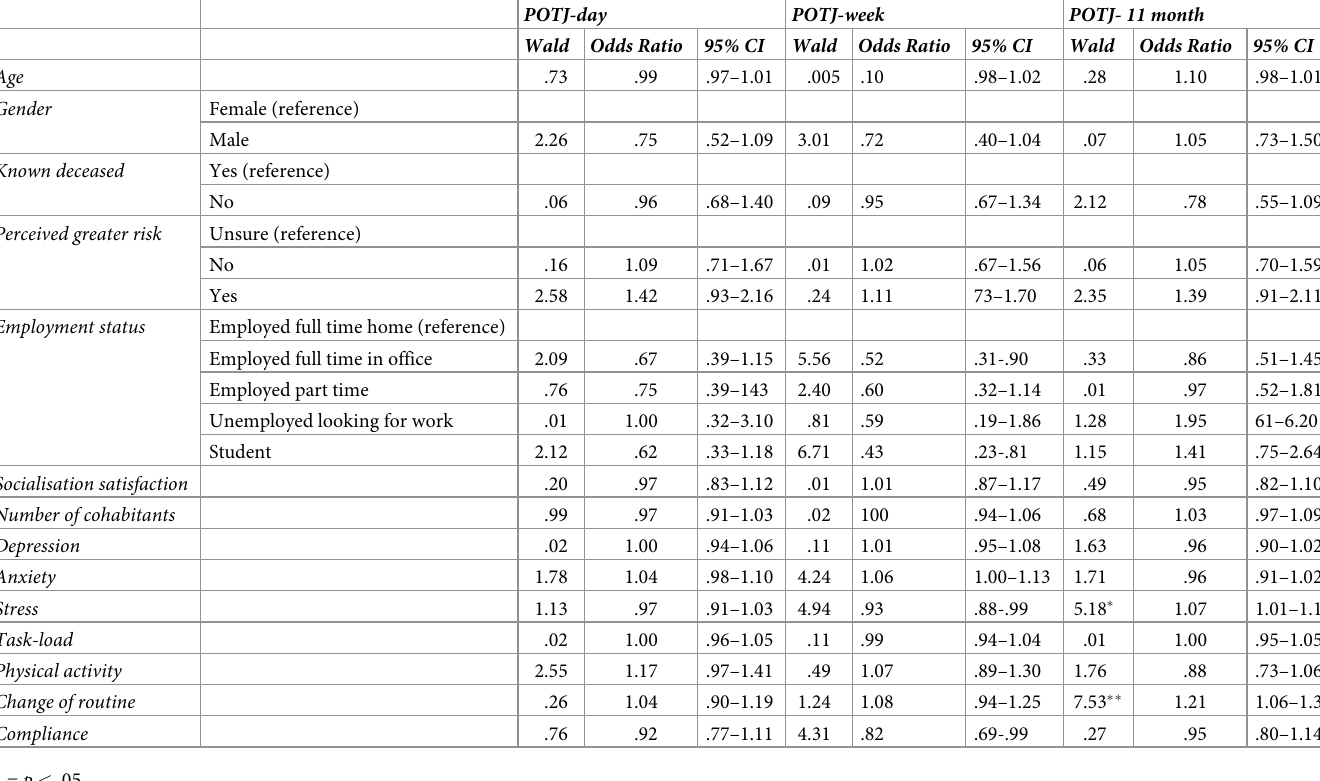
Table 4. Wald, odds ratios and 95% confidence intervals from the ordinal regressions for POTJ-day, POTJ-week and POTJ-11